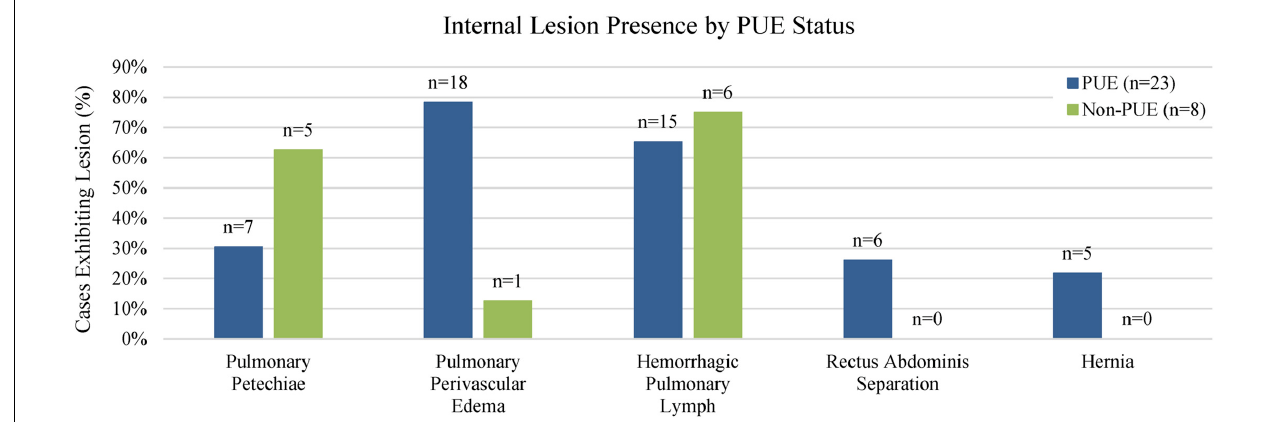
FIGURE 5 | Lesions present in bottlenose dolphins. Pulmonary petechiae and hemorrhagic pulmonary lymph were more common in non-PUE cases, while rectus abdominis separations and hernias were only found in PUE cases. Pulmonary perivascular edema was the most common lesion observed in PUE cases.